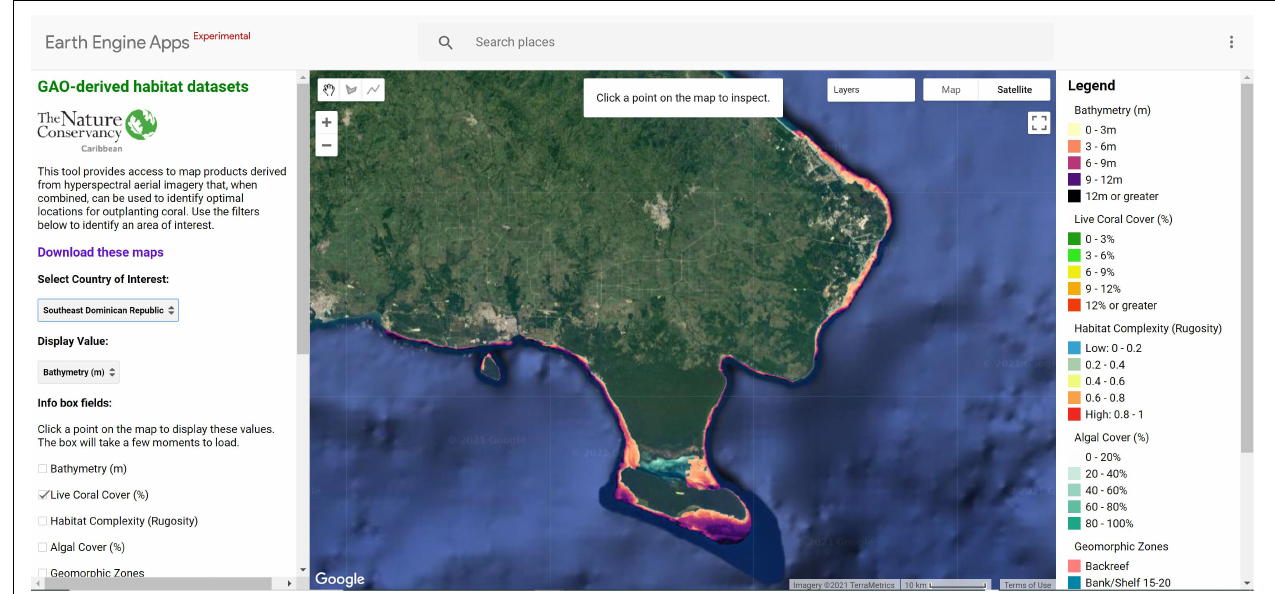
FIGURE 9 | The Coral Outplanting Siting Guide, a Google Earth Engine (GEE) app, an open-source web browser-based tool that provides coral managers the ability to dynamically model and select outplanting locations based on site-specific or coral species-specific criteria. The tool allows users to interact with large spatial datasets without requiring software installation, technical knowledge, or data storage